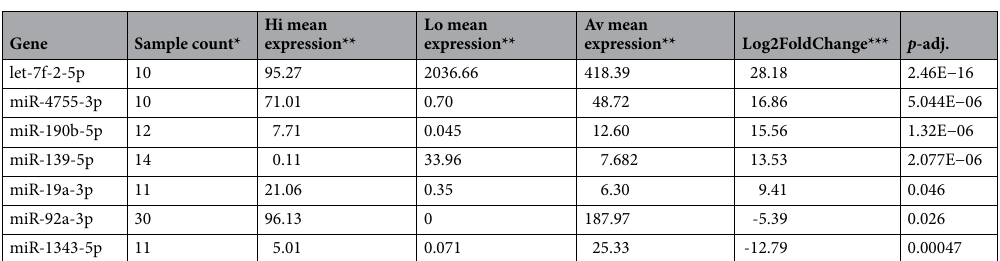
Table 2. Top Differentially Expressed miRNAs. *Only differentially expressed small RNAs present in 10 or more samples are included. **Expression values for the high, low and average blastocyst rate groups were normalized using a mean of ratios to allow for gene count comparisons between and within samples. ***Positive ‘log2foldchange’ values indicate up-regulation in the Hi group.